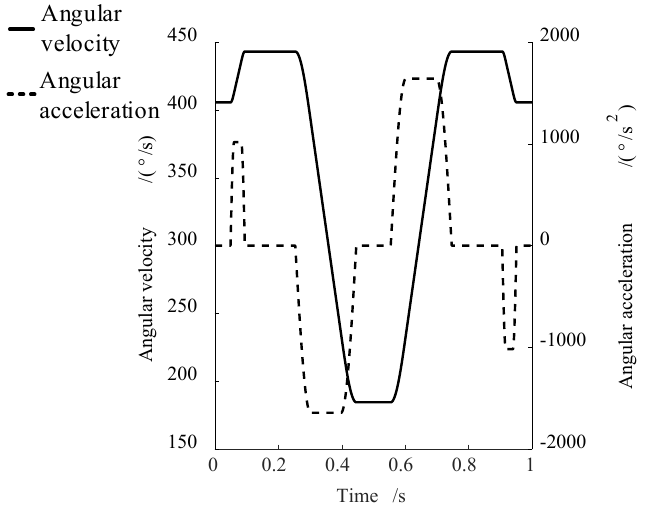
Figure 17. ω 4 curve after optimization. Figure 17 . ω 4 curve after optimization.